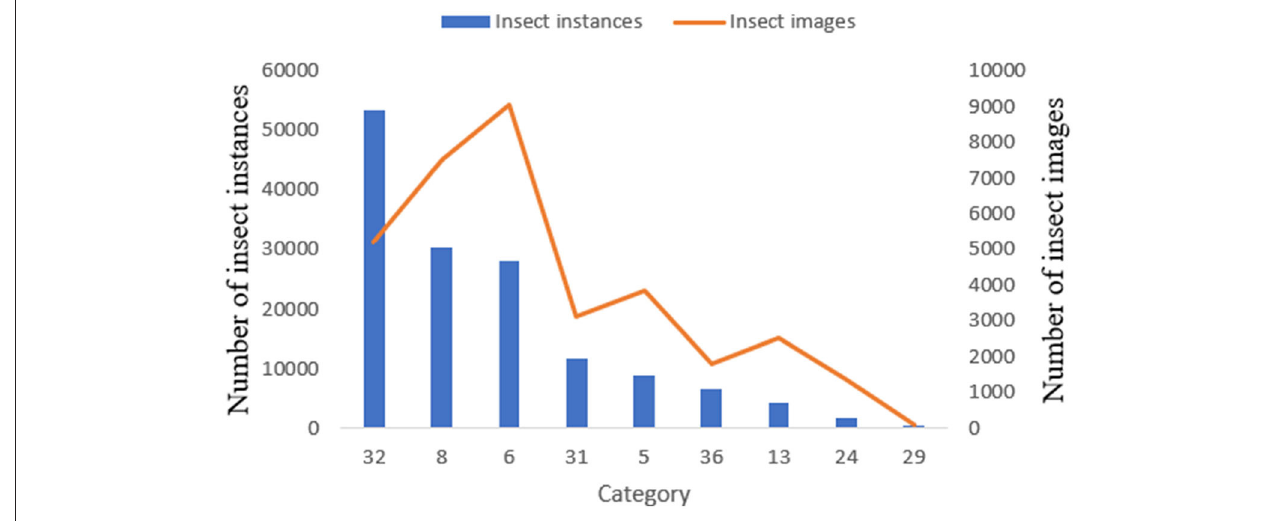
FIGURE 1 | The number of instances and images for each pest category.